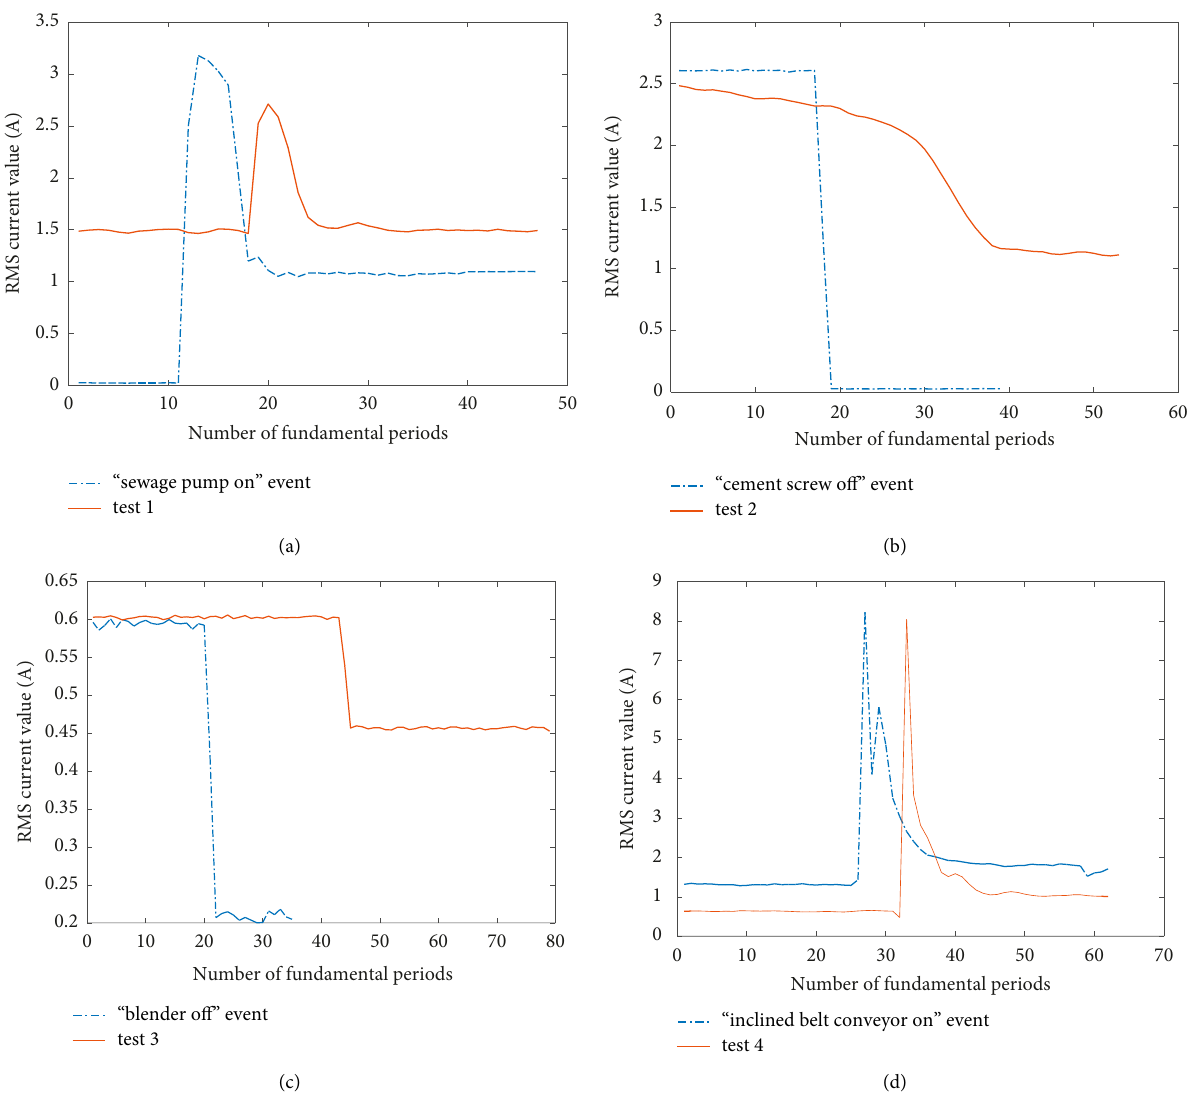
Figure 6: Load identification results underlying on